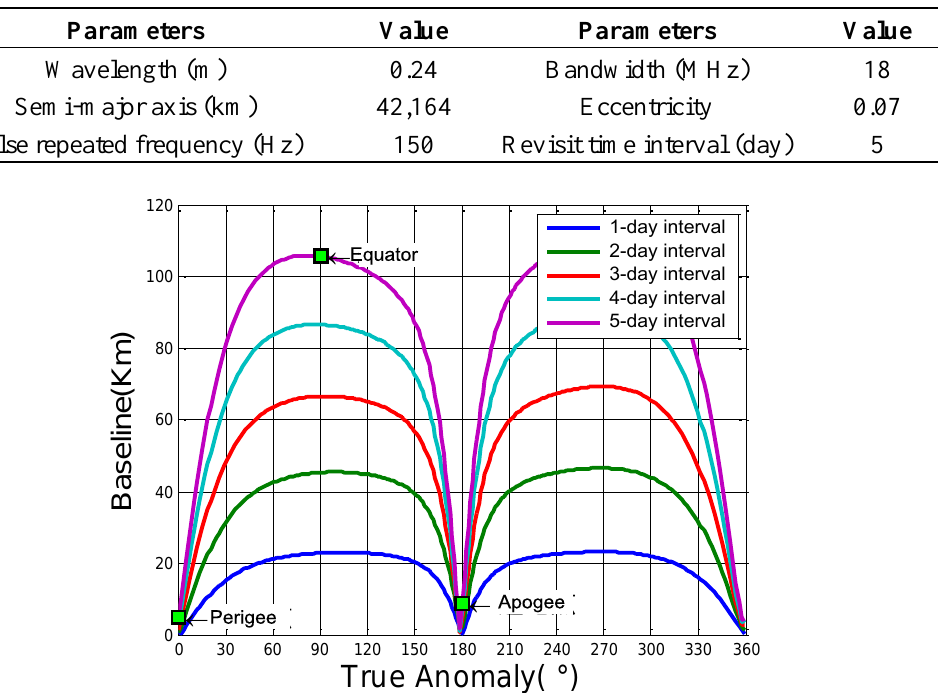
Figure 5. GEO InSAR baseline with respect to various time